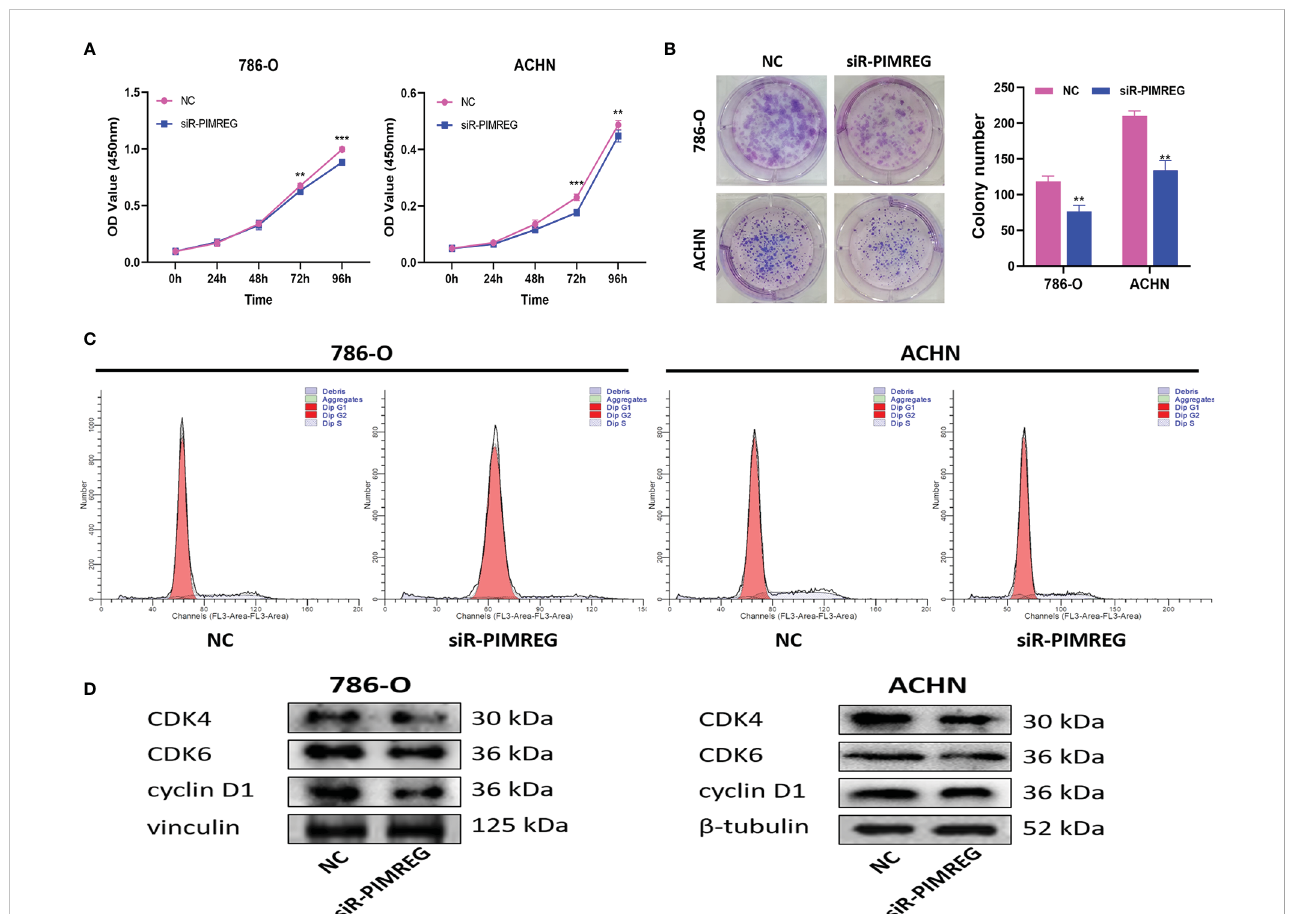
FIGURE 11 PIMREG promotes ccRCC cells proliferation in vitro . (A) CCK-8 assay indicated that knockdown of PIMREG reduced the proliferation ability of ccRCC cells. (B) Colony formation assay indicated that knockdown of PIMREG reduced the proliferation ability of ccRCC cells. (C) Flow cytometry indicated that knockdown of PIMREG inhibit the cells transition from G1 phase to S phase. (D) Western blot indicated that the expression levels of cell cycle related proteins decreased signi fi cantly after knockdown of PIMREG . ccRCC: clear cell renal cell carcinoma; **P < 0.01, ***P <